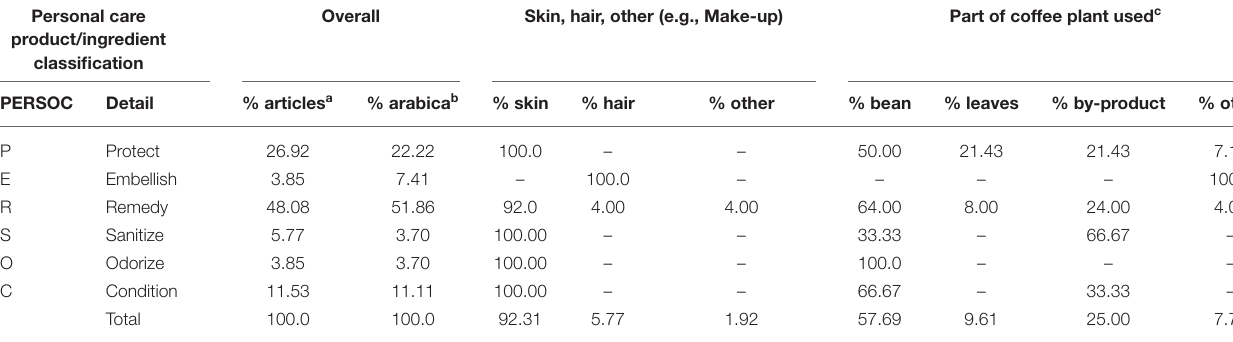
TABLE 6 | Selected statistics of overall articles. Personal care product/ingredient